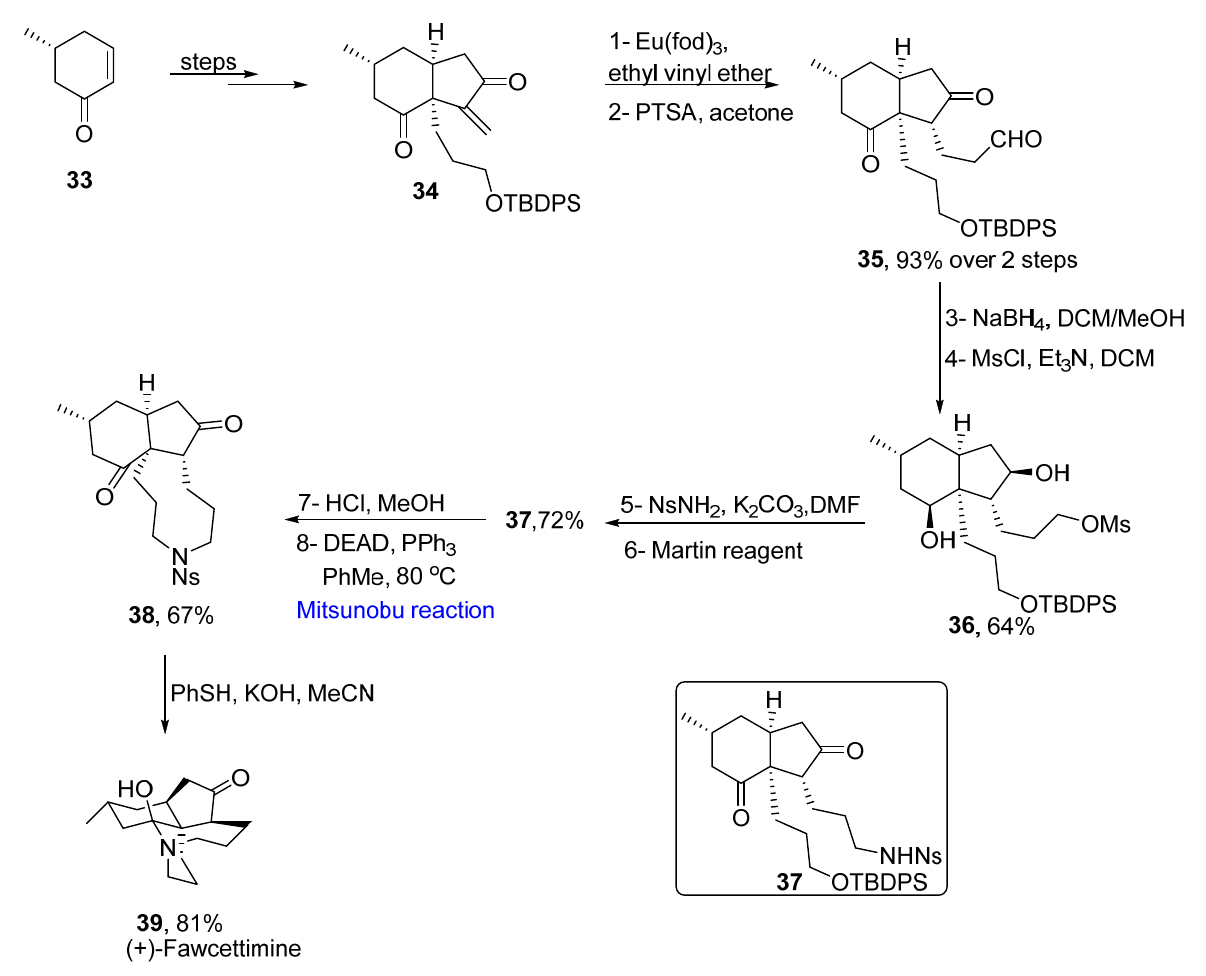
Scheme 6. Total synthesis of (+)-fawcettimine 39